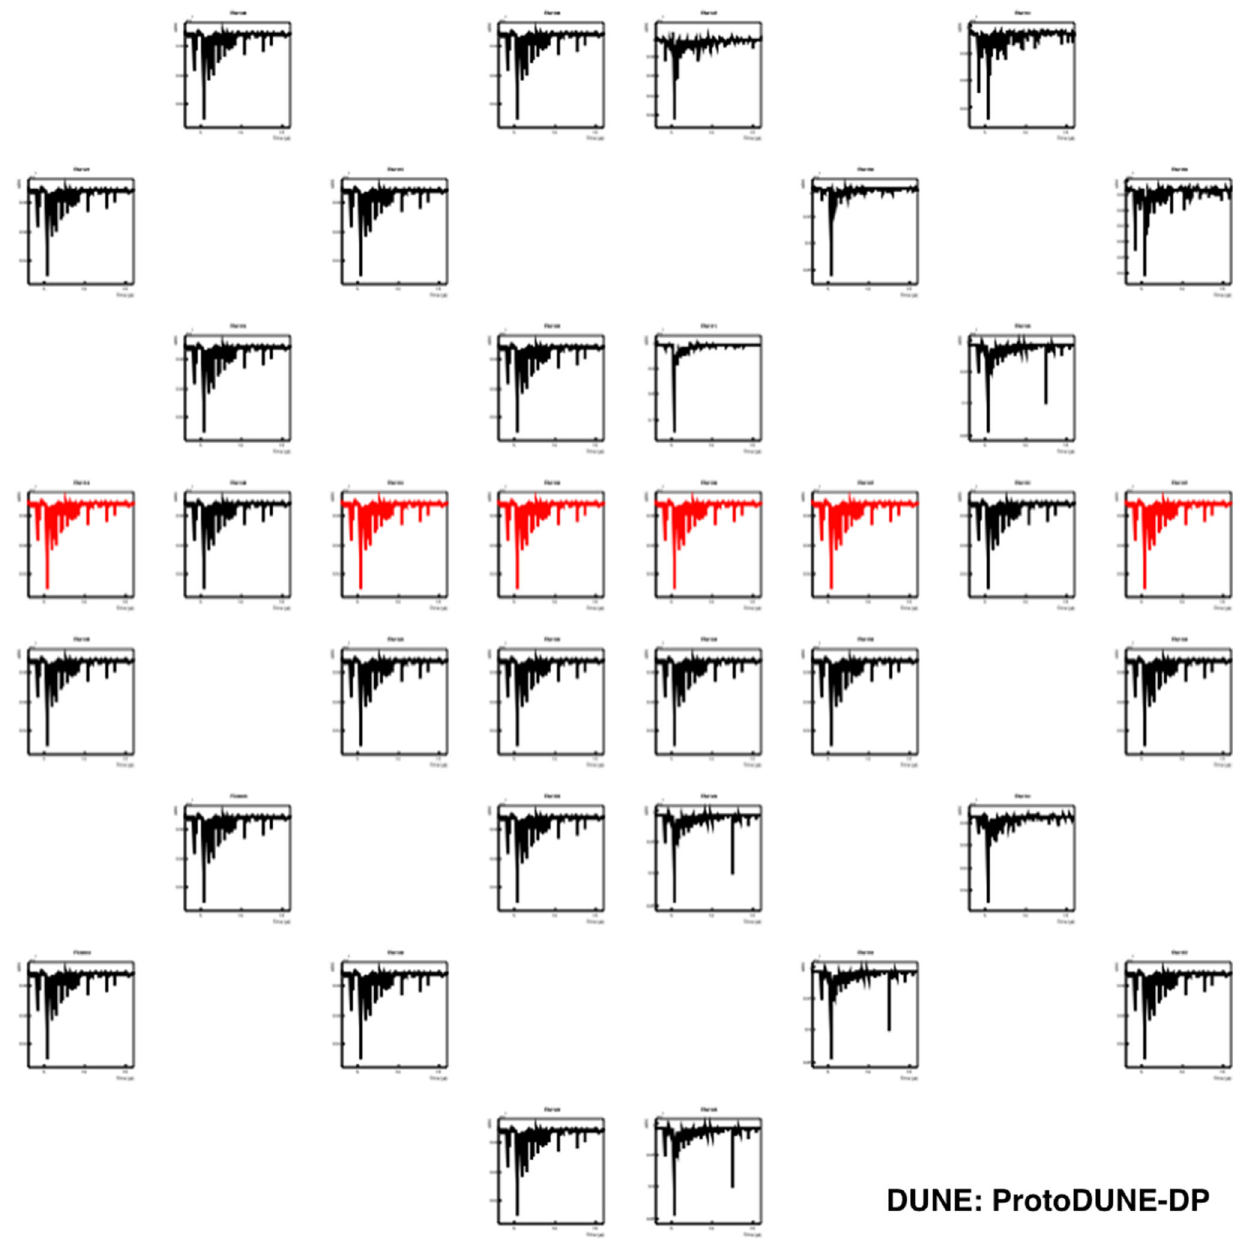
Fig. 4 Example of a PMT self-trigger event showing the waveforms corresponding to the 36 PMTs according to their relative position in the detector. The PEN PMTs are shown in black and TPB PMTs in red.